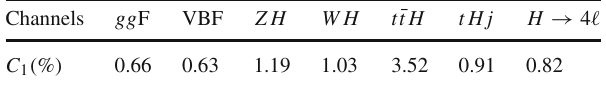
Table 1 C 1 for different Higgs production processes at 13 TeV LHC and the H → 4 (cid:2) decay